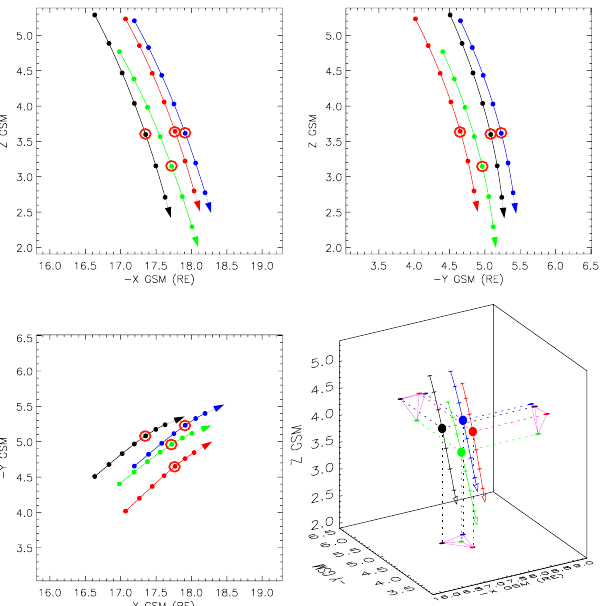
Fig. 1. Tetrahedron configuration in the GSM coordinate system for 18 August 2002 between 15:00:00 and 18:00:00UT. Red cir- cles indicate the configuration at 17:00:00, approximate time of the event. Black, Red, Green and Blue indicate Cluster 1, 2, 3 and 4, respectively.